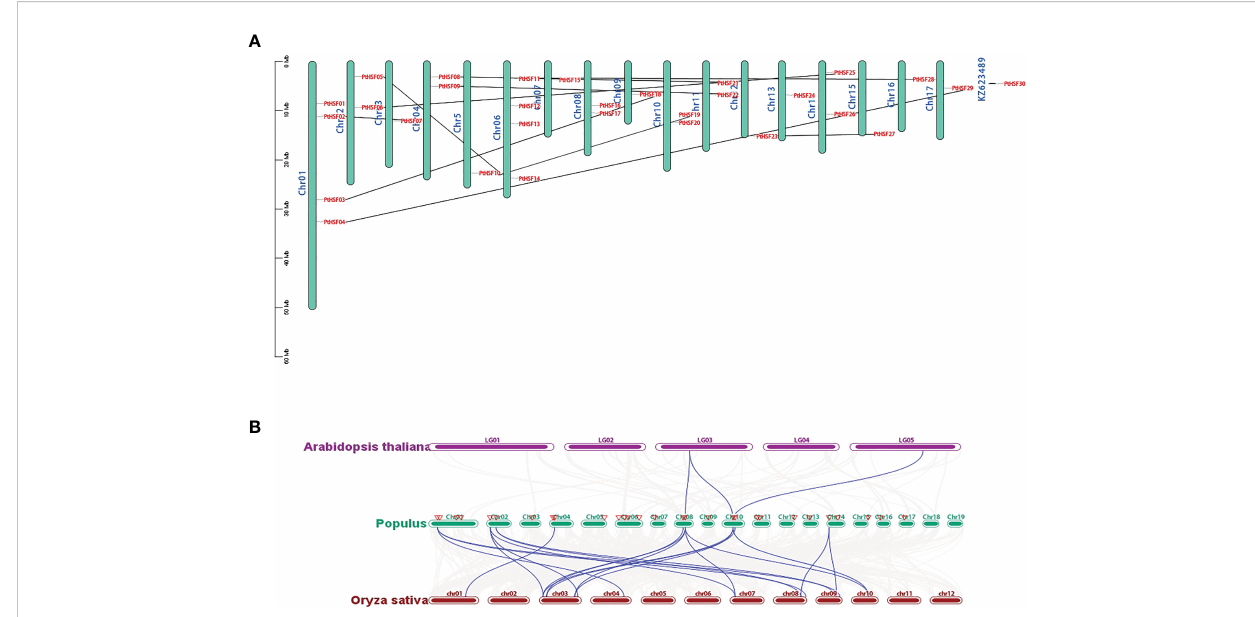
FIGURE 4 Repetition and collinearity analysis of PtHSFs fragments. (A) Approximately 30 HSF genes were unevenly distributed on poplar chromosomes, and the segmental repetition relationships were represented by black lines. (B) Collinearity analysis of HSF genes in poplar, Arabidopsis , and rice. The blue line represents the HSF lineal homologous gene pairs, and the red triangle indicates PtHSFs.